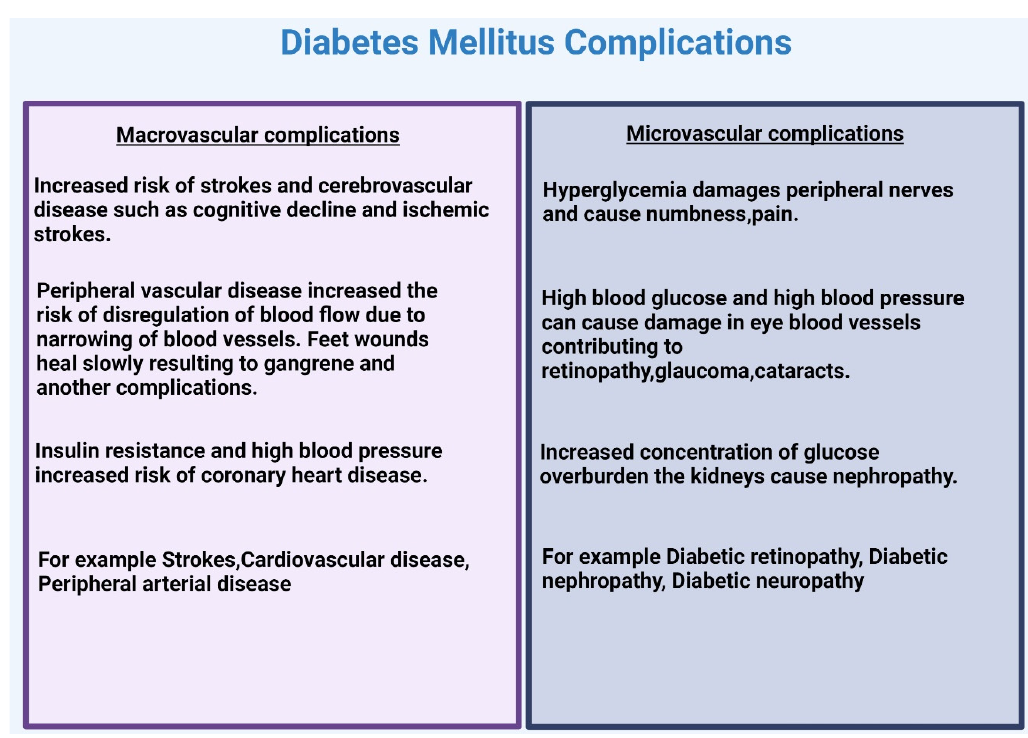
Figure 4. Long ‐ term diabetic complications can result in microvascular and microvascular prob ‐ Figure 4. Long-term diabetic complications can result in microvascular and microvascular problems. lems. Diabetic patients and their immediate care. Created with BioRender.com. Diabetic patients and their immediate care. Created with